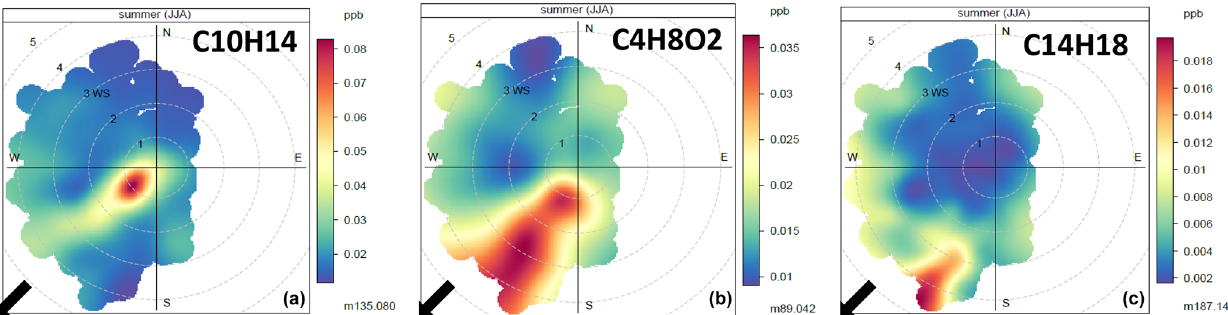
Figure 9. Three typical wind roses of compounds identified as coming from the farm. Colours show the mixing ratios, and plots are binned by averaged wind direction and wind speeds. (a) Constantly emitting source (C 10 H 14 ). (b) Source emitting with a daily pattern (C 4 H 8 O 2 ). (c) Secondary photo-produced compound (C 14 H 18 ). The arrows indicate the direction of the main farm